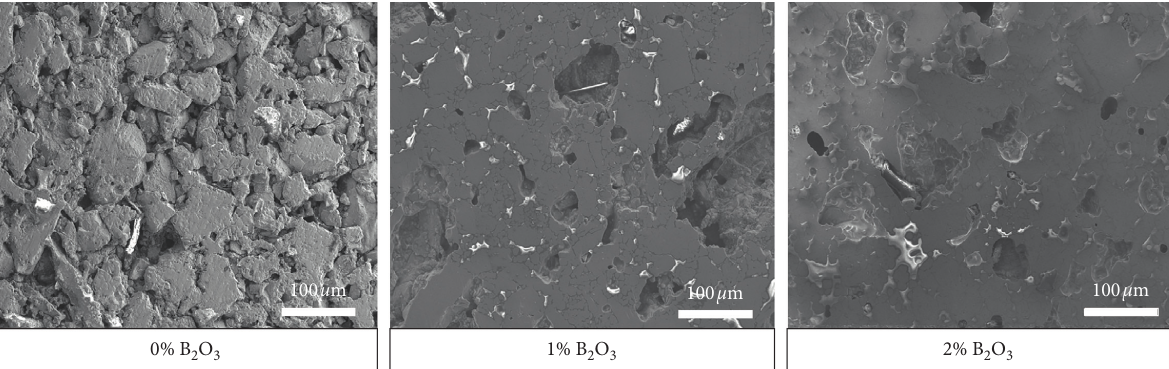
Figure 6: SEM images of pellets with different B